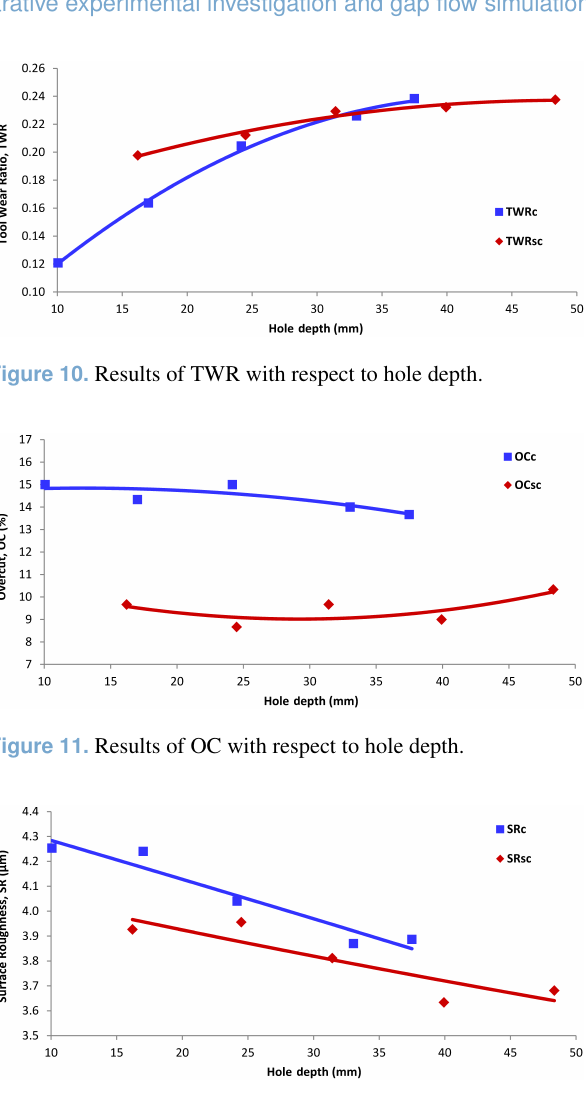
Figure 12. Results of SR with respect to hole